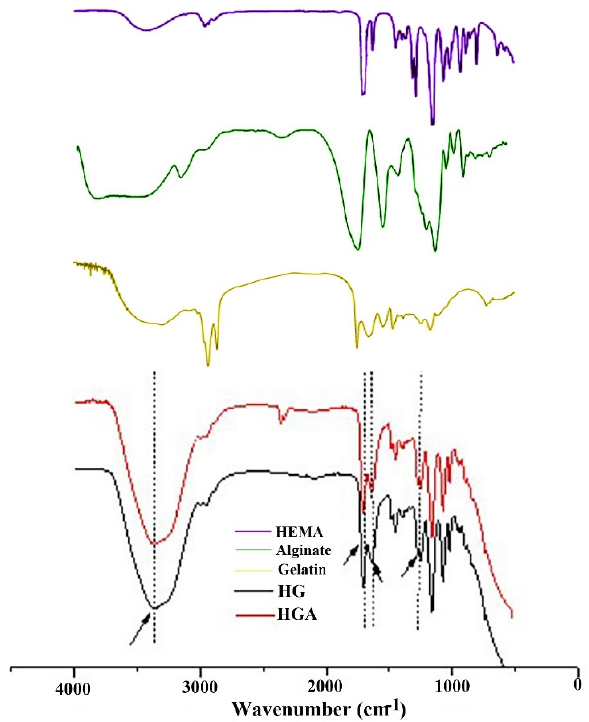
Figure 1. FTIR spectra of each component of scaffolds and hydrogel scaffolds.